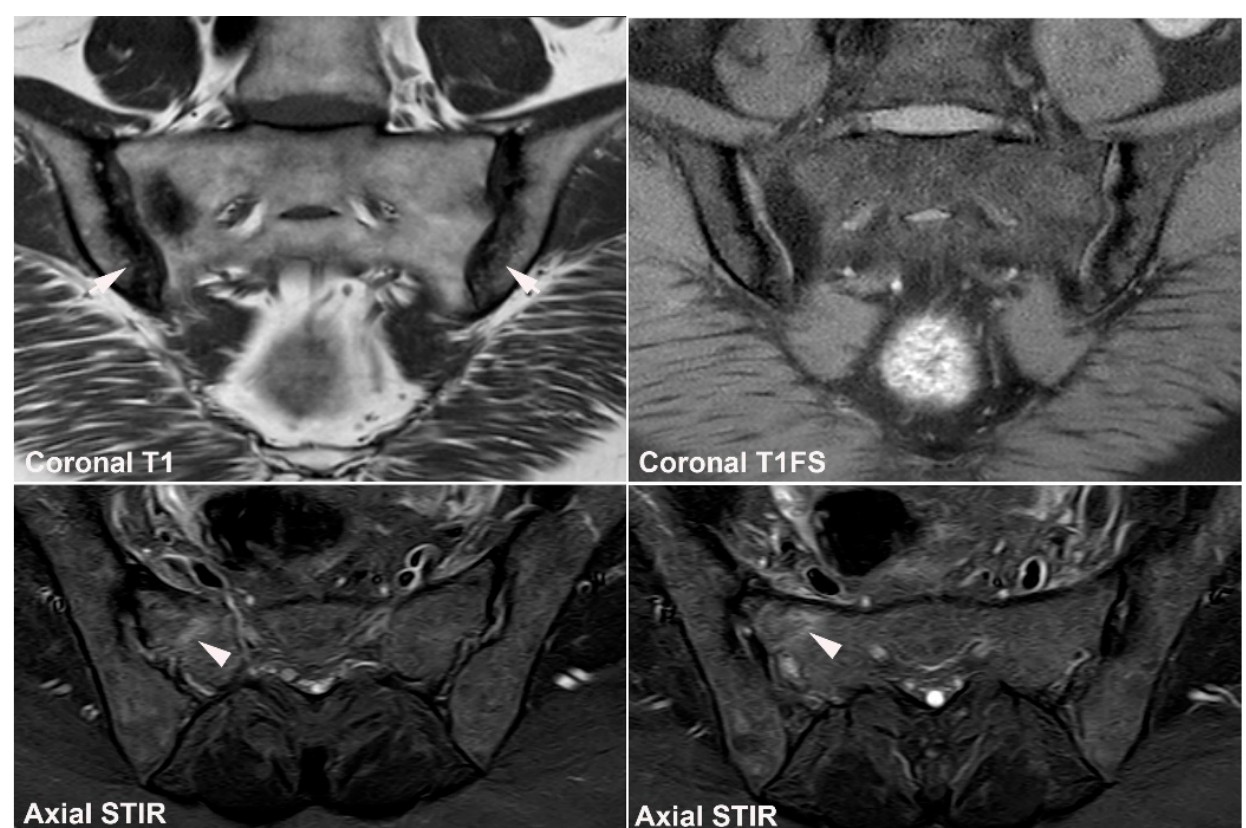
Figure 30. Hyperparathyroidism in a 54-year-old man with renal insufficiency complaining of low back pain. MRI, semi-coronal T1, and T1FS and two semi-axial STIR images at S1 (left image) and S2, respectively, showing irregular iliac joint margins with subchondral sclerosis intermingled with small fat depositions (arrows). There are well-delineated sacral joint margins, but an area with BME in the right side of S1 (arrowheads).